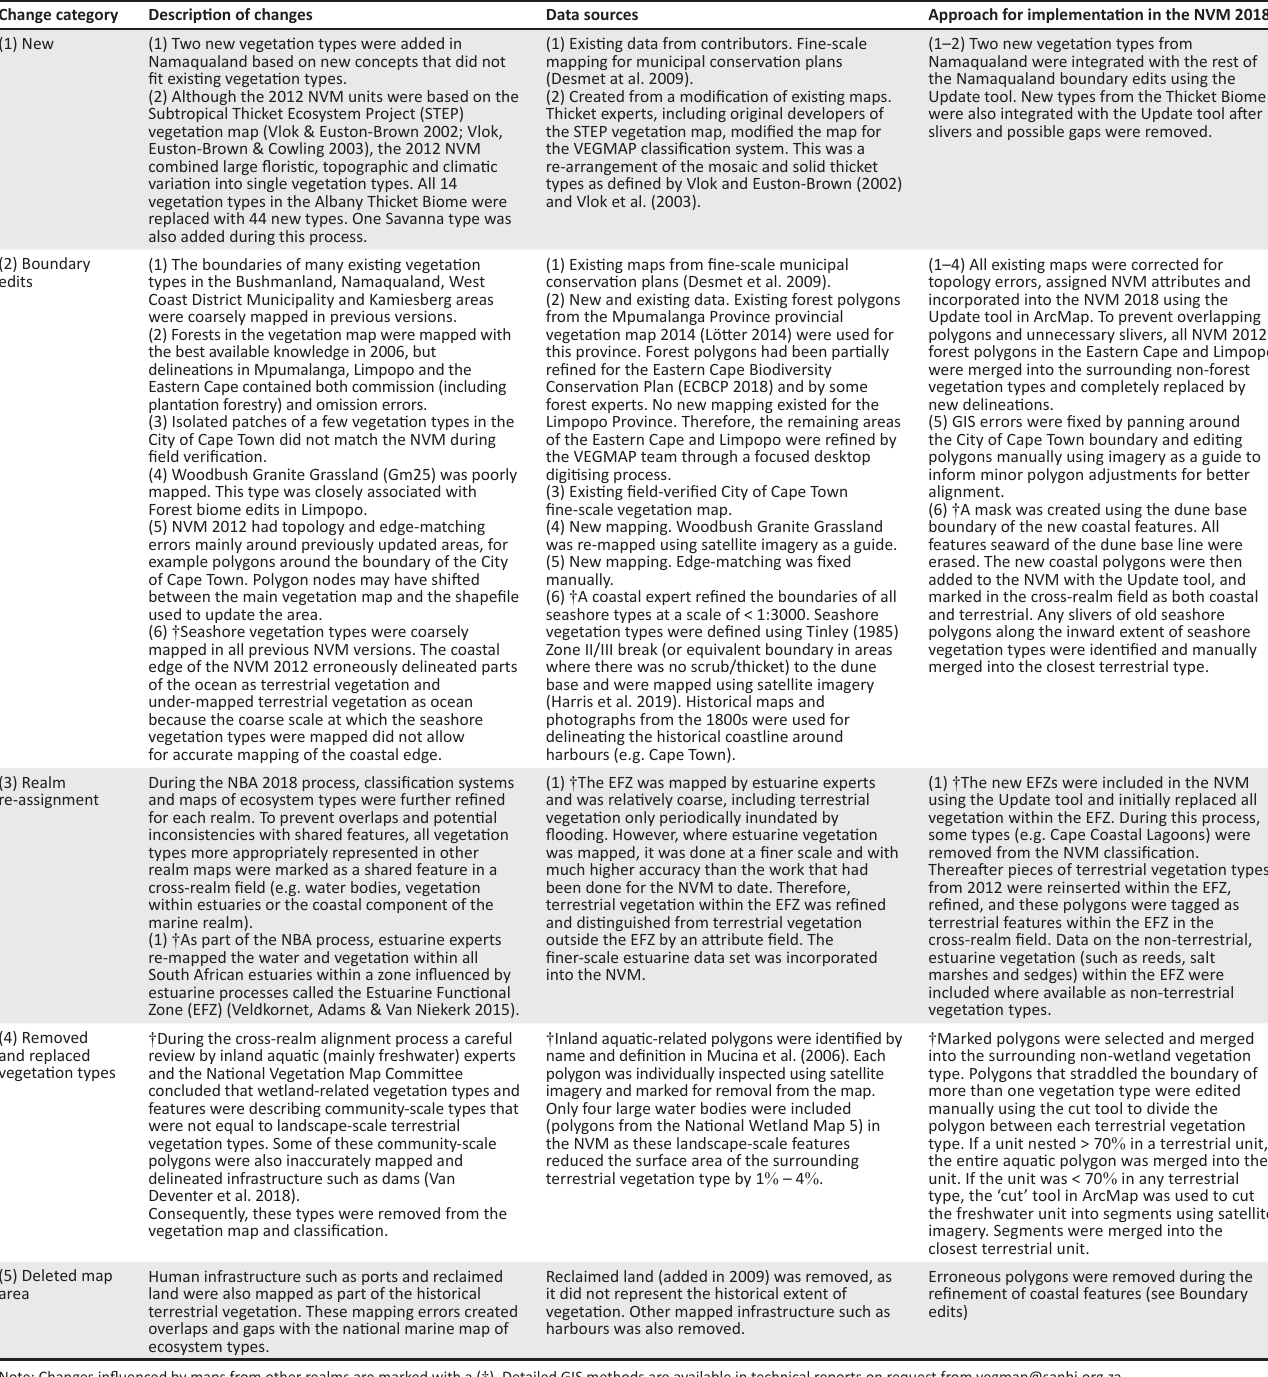
TABLE 1: The five main categories of changes included in the update of the 2018 version of the National Vegetation Map, the rationale for implementing these changes, data sources and methods used for integration with the map. Change category Description of